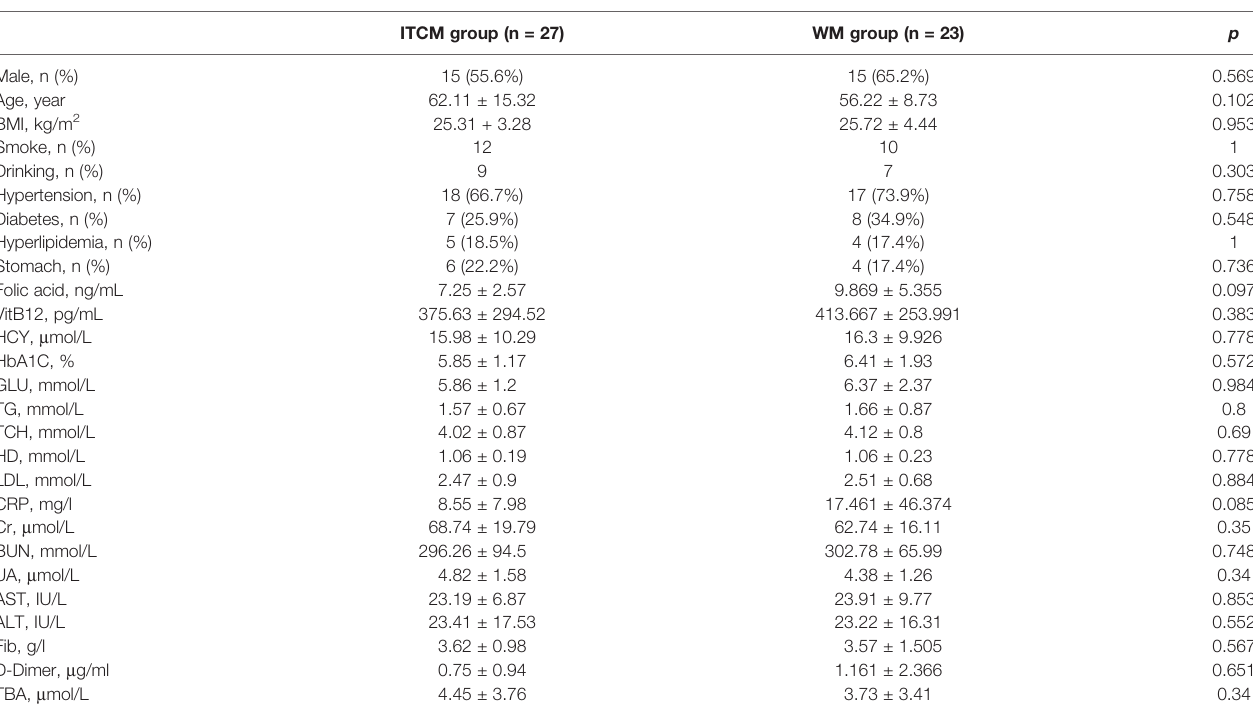
TABLE 1 | The basic information of the ITCM treatment group and WM treatment